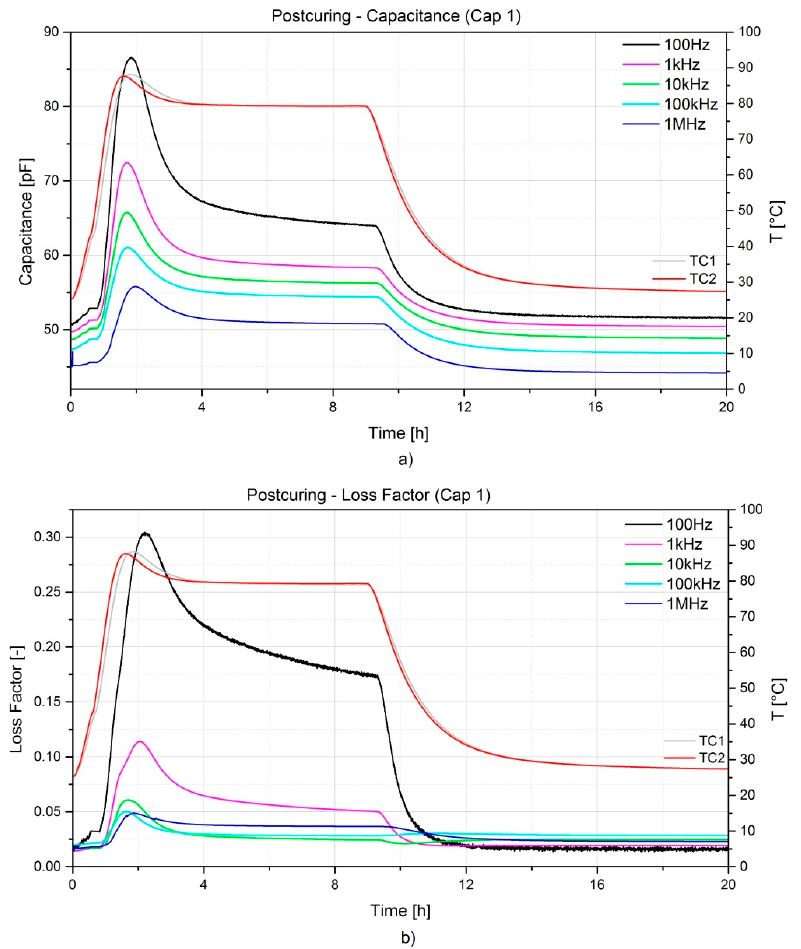
Figure 7. Capacitance ( a ) and dissipation factor ( b ) evolution during the post-curing at 80 °C for 8 h in the oven for the A380 hinge arm.